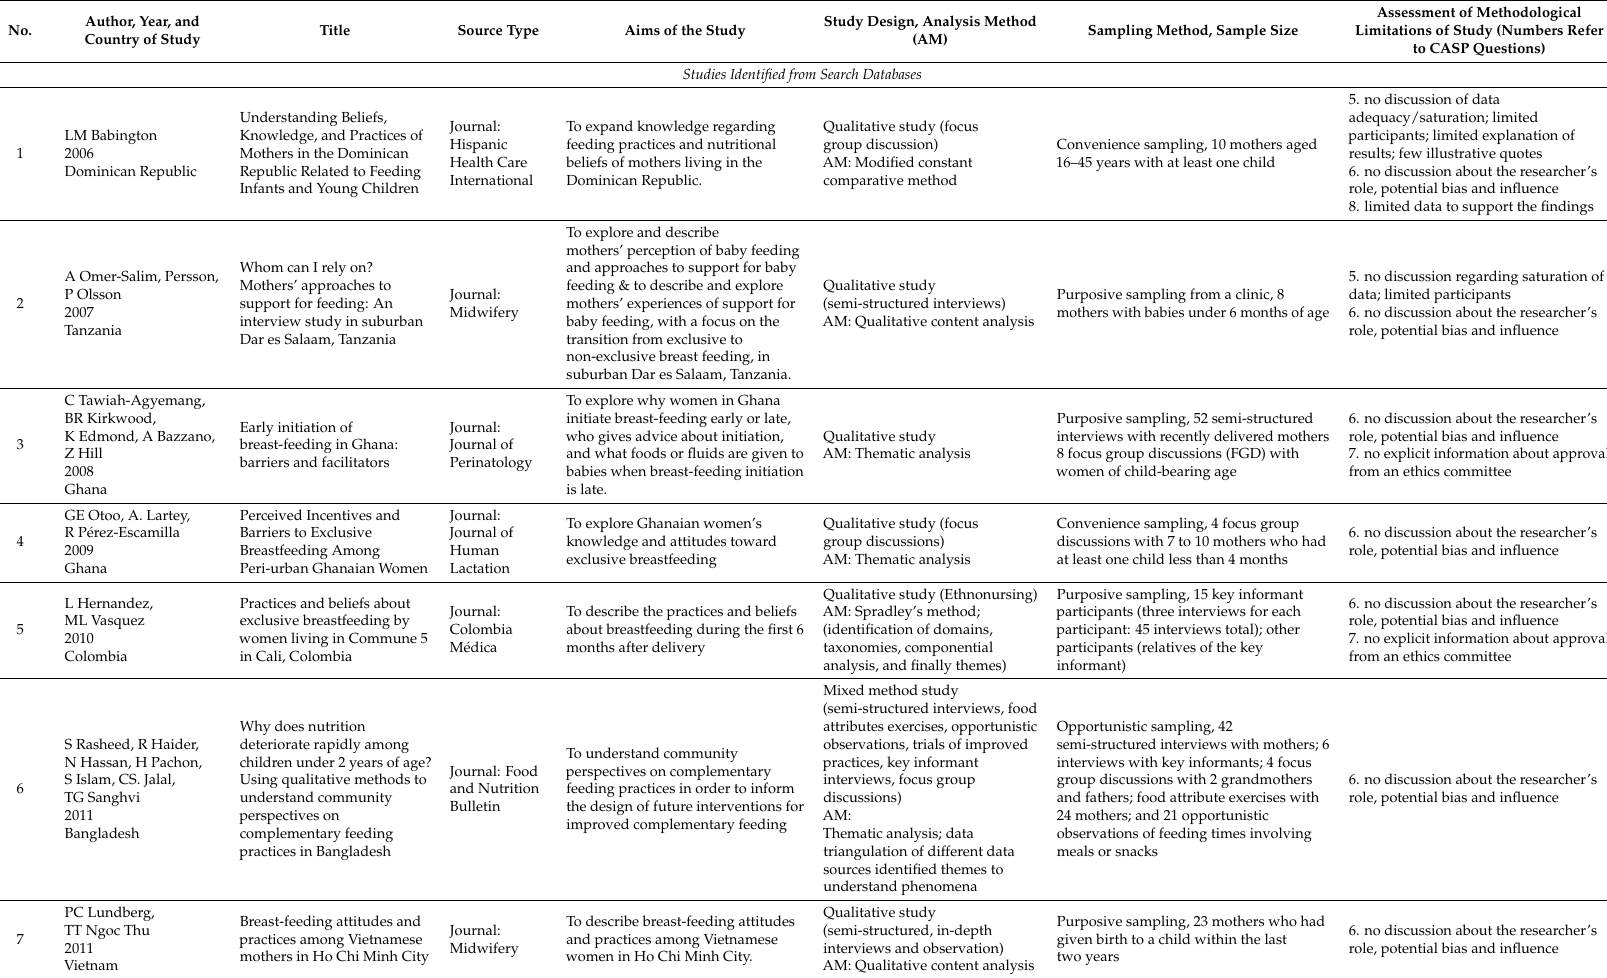
Table 1. Data extraction of studies included in review including bibliographic information, study details and assessment of methodological limitations.